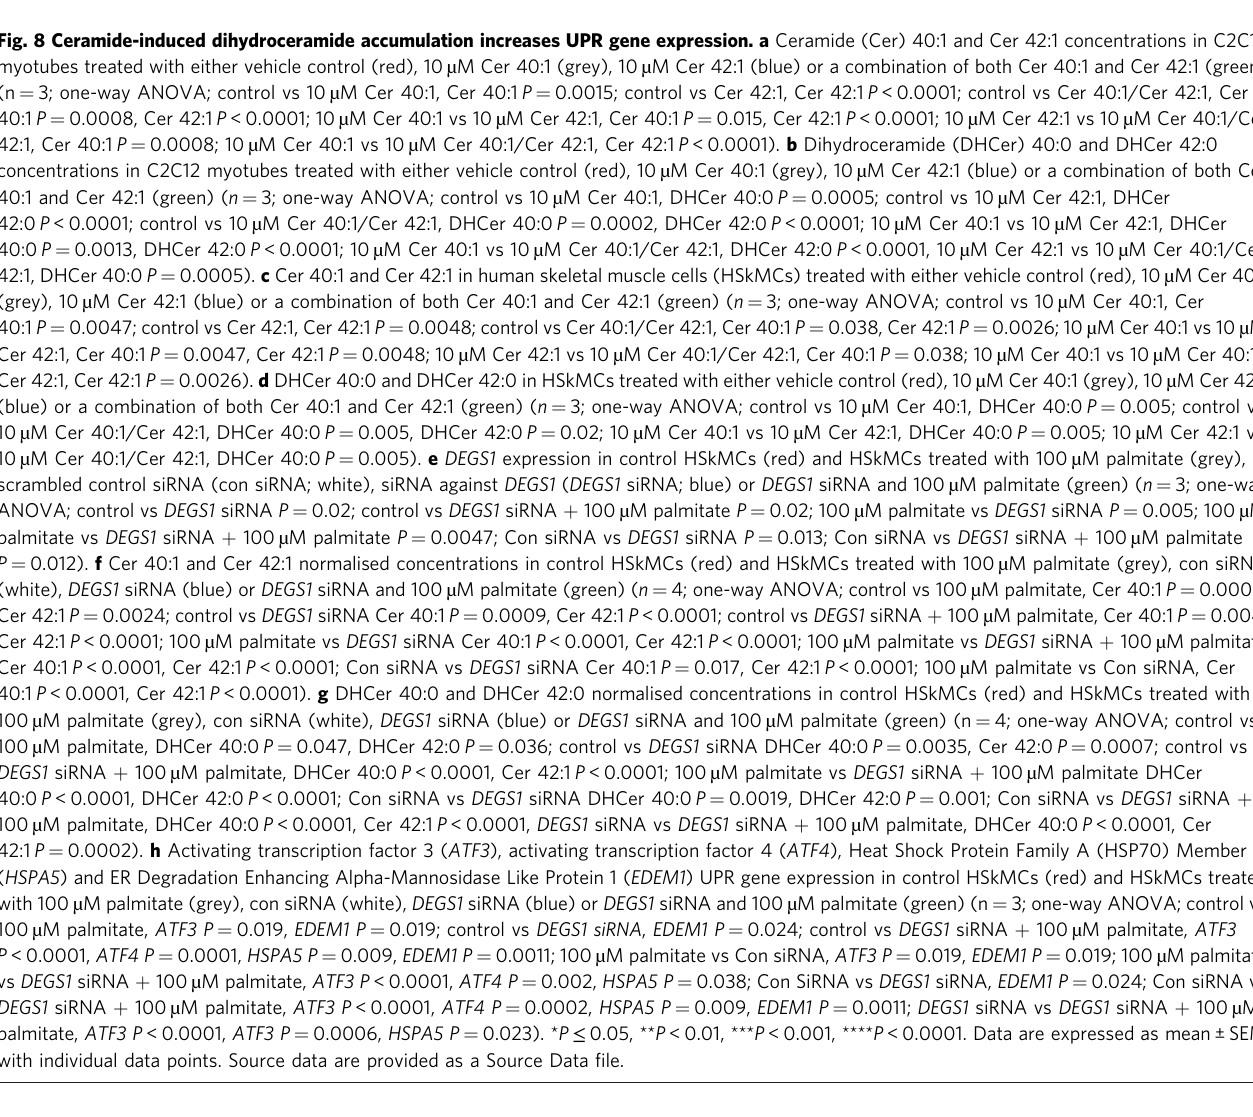
Fig. 8 Ceramide-induced dihydroceramide accumulation increases UPR gene expression. a Ceramide (Cer) 40:1 and Cer 42:1 concentrations in C2C12 myotubes treated with either vehicle control (red), 10 µ M Cer 40:1 (grey), 10 µ M Cer 42:1 (blue) or a combination of both Cer 40:1 and Cer 42:1 (green) (n = 3; one-way ANOVA; control vs 10 µ M Cer 40:1, Cer 40:1 P = 0.0015; control vs Cer 42:1, Cer 42:1 P < 0.0001; control vs Cer 40:1/Cer 42:1, Cer 40:1 P = 0.0008, Cer 42:1 P < 0.0001; 10 µ M Cer 40:1 vs 10 µ M Cer 42:1, Cer 40:1 P = 0.015, Cer 42:1 P < 0.0001; 10 µ M Cer 42:1 vs 10 µ M Cer 40:1/Cer 42:1, Cer 40:1 P = 0.0008; 10 µ M Cer 40:1 vs 10 µ M Cer 40:1/Cer 42:1, Cer 42:1 P < 0.0001). b Dihydroceramide (DHCer) 40:0 and DHCer 42:0 concentrations in C2C12 myotubes treated with either vehicle control (red), 10 µ M Cer 40:1 (grey), 10 µ M Cer 42:1 (blue) or a combination of both Cer 40:1 and Cer 42:1 (green) ( n = 3; one-way ANOVA; control vs 10 µ M Cer 40:1, DHCer 40:0 P = 0.0005; control vs 10 µ M Cer 42:1, DHCer